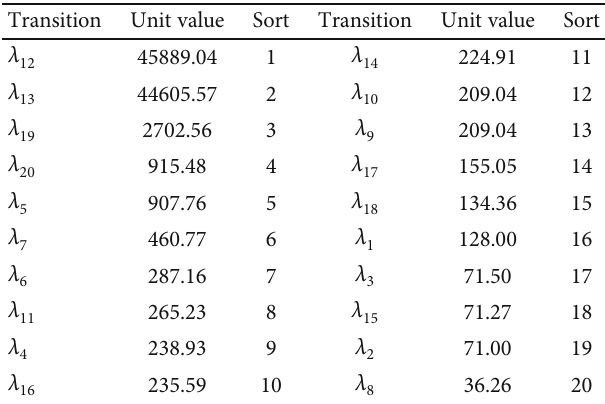
Table 5: Changed value of the total time of the ER system when the transition unit